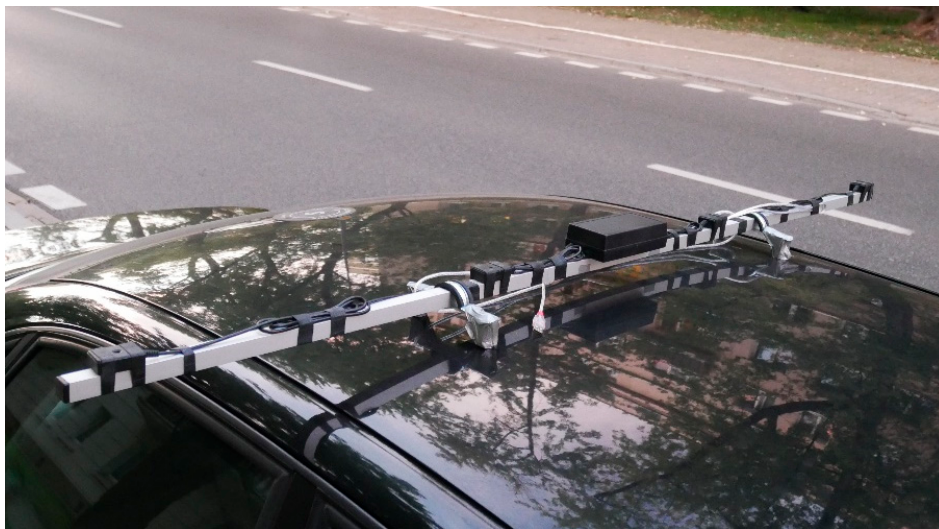
Figure 4. View of the proprietary measurement system on the vehicle roof.